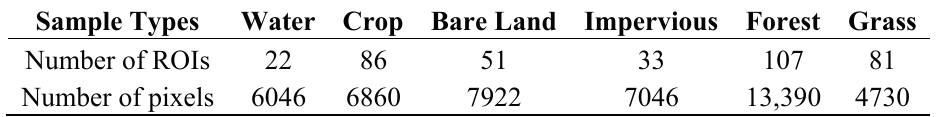
Table 1. Number of ROIs and pixels used for training and validating the